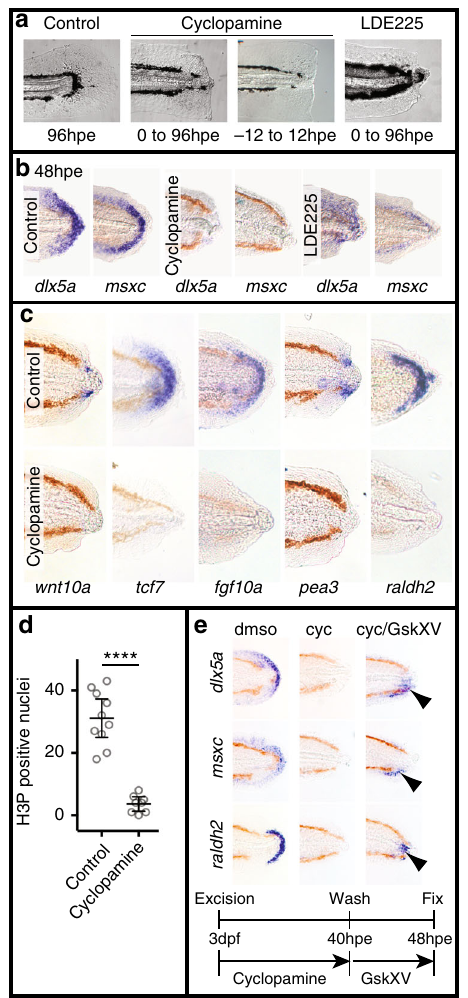
Fig. 3 Hedgehog signalling plays a central role during larval tail regeneration. a Continuous treatment with the Hedgehog pathway inhibitors cyclopamine (20 μ M) and LDE225(20 μ M) blocks regeneration (Cyclopamine 10/10, LDE 10/10, number of experiments = 2) (Control 20/ 20, number of experiments = 4). Cyclopamine pulse treatment blocks regeneration (8/10, number of experiments = 2). b Larvae treated with cyclopamine (20 μ M) and LDE225 (20 μ M) from 0 to 48 hpe have reduced expression of dlx5a and msxc (for all panels results are 10/10, number of experiments = 2). c Wound-induced expression of markers for the Wnt/ β - Catenin, FGF and RA pathways is lost after treatment with cyclopamine. Larvae in the wnt10a and pea3 panels were treated with 50 μ M cyclopamine from 0 to 30 hpe. tcf7, fgf10a and raldh2 panels were treated with 20 μ M cyclopamine from 0 to 48 hpe (for all panels results are 10/10, number of experiments = 2). d Cell proliferation is inhibited by treatment with cyclopamine (control n = 10, cyclopamine n = 8, number of experiments = 2). This analysis was done as in Fig. 1d. Unpaired t test two-tailed results in P < 0.0001 indicated as ****. e Upregulation of Wnt/ β -Catenin signalling after cyclopamine treatment restores expression of dlx5a , msxc and raldh2 (for all panels results are 10/10, number of experiments = 3). Arrowheads indicate partial rescue of marker expression. Larvae were treated from 0